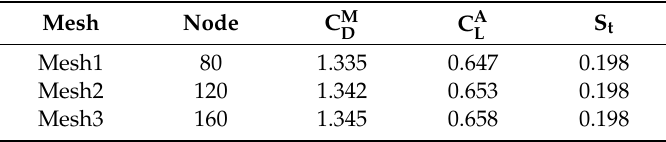
Table 2. Results for mesh independent